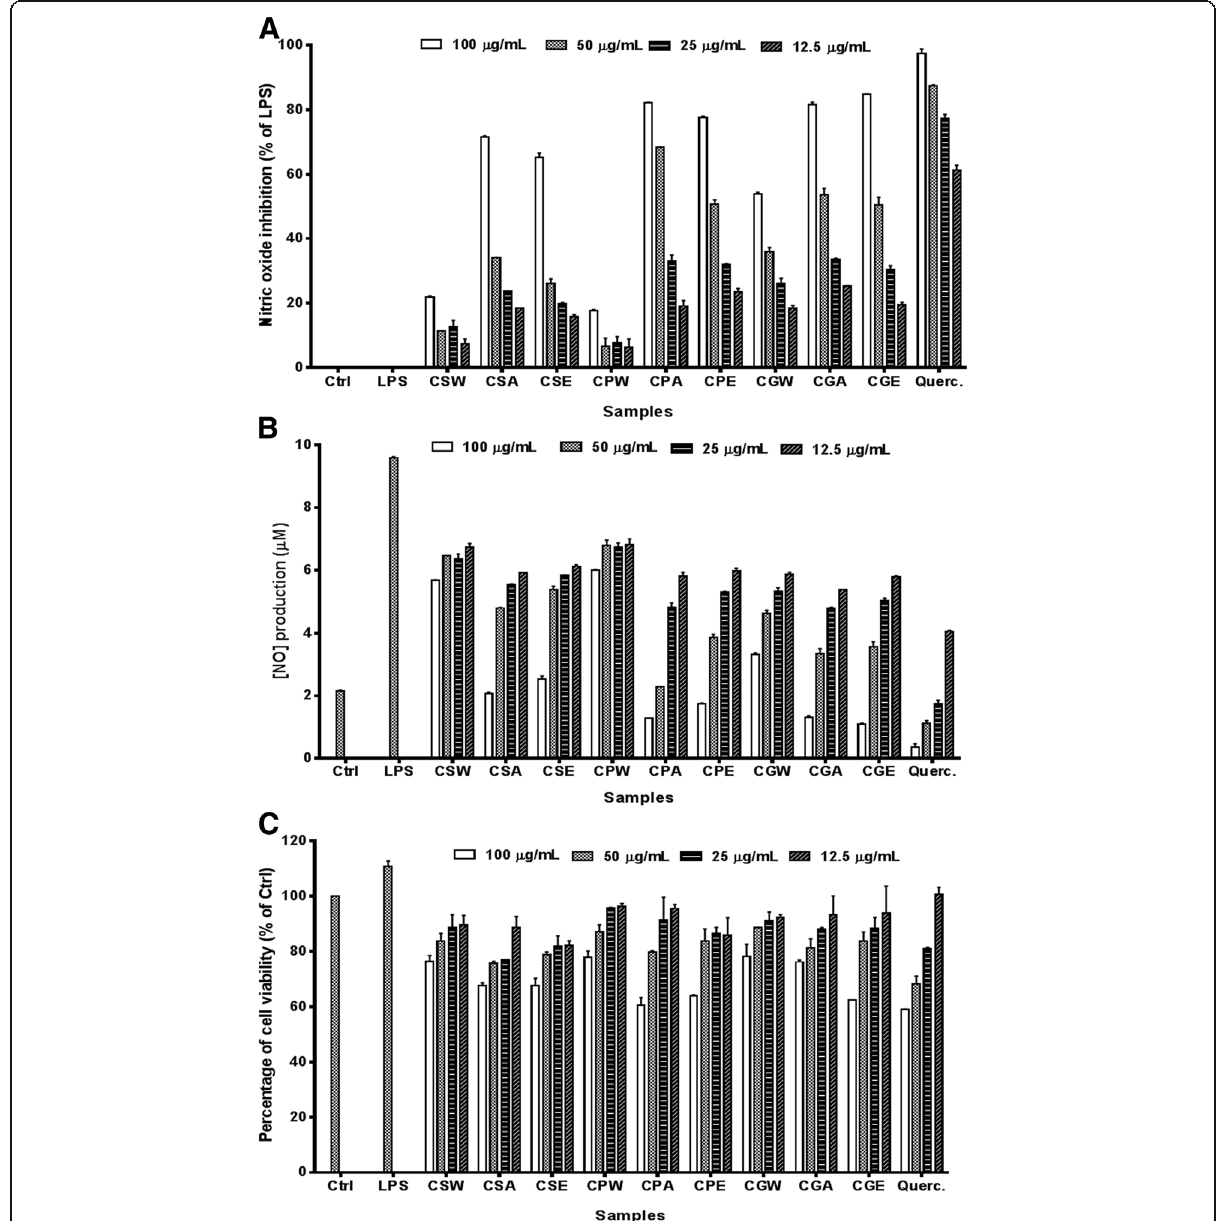
Fig. 1 Activities of the extracts from three Croton species on the percentage of nitric oxide inhibition ( a ), nitric oxide production ( b ) and cell viability ( c ) on LPS-stimulated RAW 264.7 macrophages. Data are presented as means of triplicate measurements ± standard error. CSA, CSE and CSW represent respectively acetone, ethanol and water extracts of Croton sylvaticus. CPA, CPE and CPW represent respectively acetone, ethanol and water extracts of Croton pseudopulchellus. CGA, CGE and CGW represent respectively acetone, ethanol and water extracts of Croton gratissimus . Ctrl: control group (0.5% DMSO); LPS: